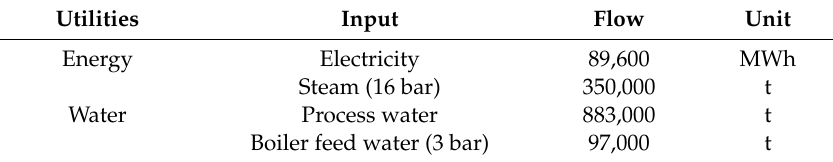
Table A2. Detailed description of utilities required per year [16–18].